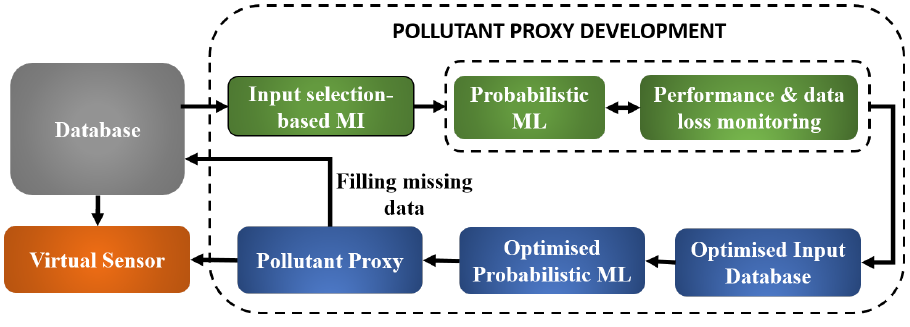
Figure 1. The block diagram of general methodology for pollutant proxy